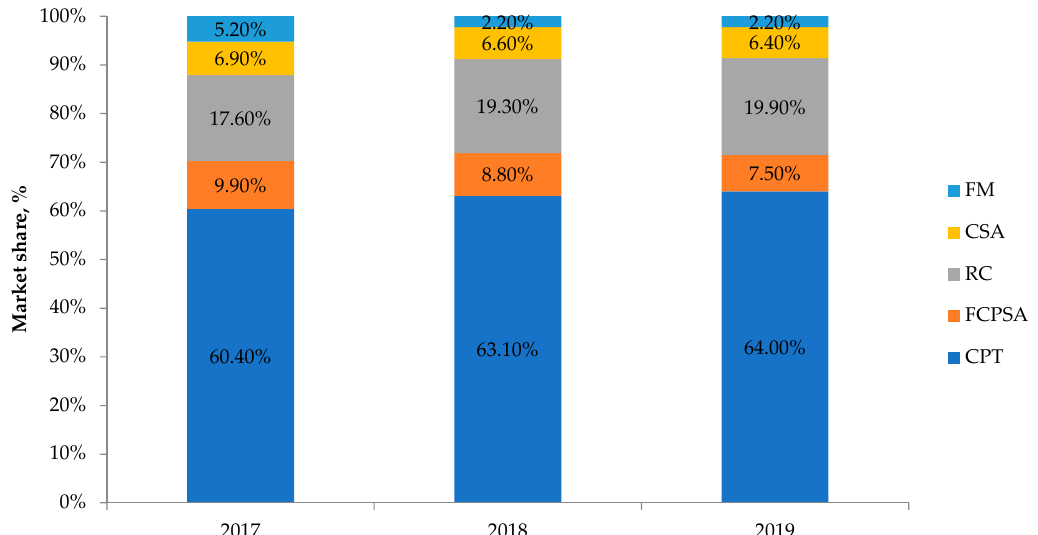
Figure 8. Volume structure of capacity trading in Russia: the second price zone. Source: own results based on